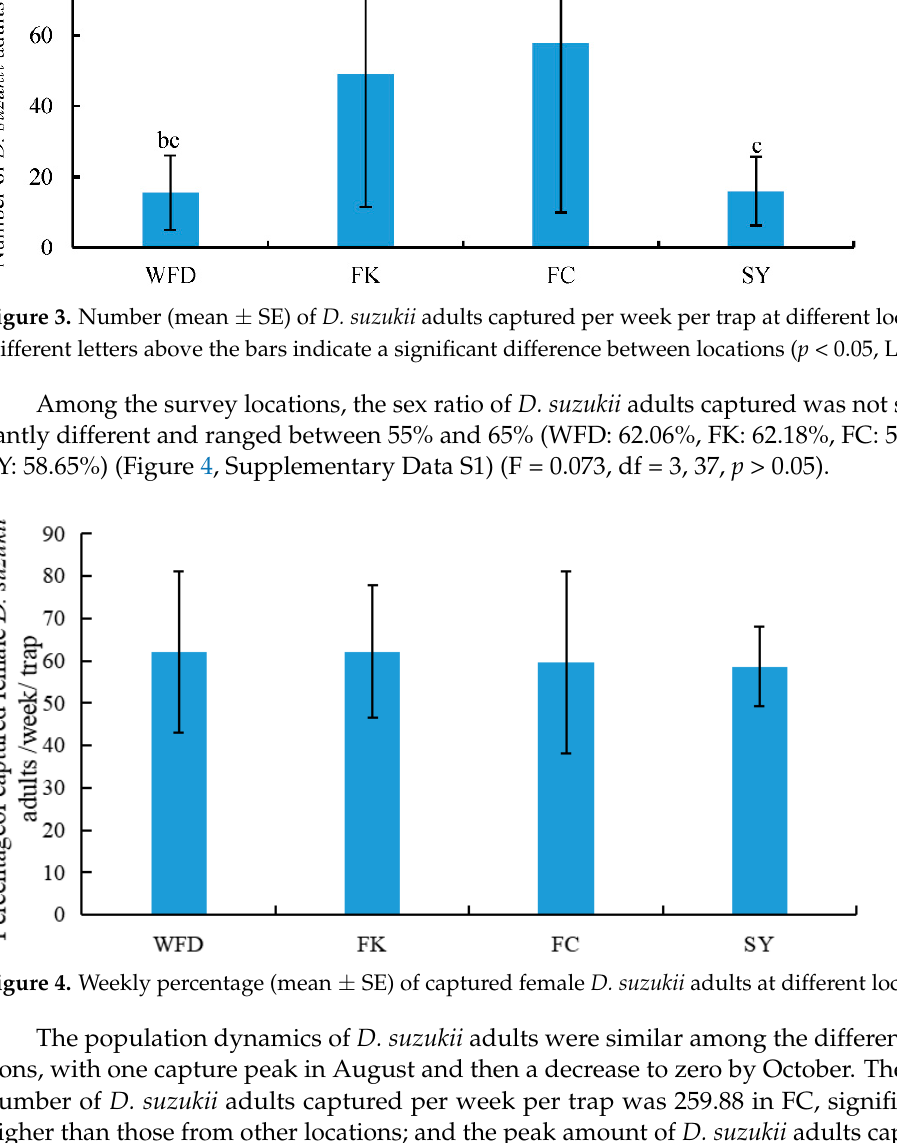
Figure 5. Mean number of D. suzukii captured per week per trap at the different locations. The num- bers on the curves indicate the sampling date (month-day). In WFD, 1–11 weeks start from 06-21 to 09-06. In FK, 1–14 weeks start from 06-22 to 09-28. In FC, 1–13 weeks start from 06-26 to 10-01. In SY, 1–5 weeks start from 07-02 to 08-06. The relative abundances of D. suzukii adults captured were not significant different between commercial fields and woods/wild bushes in WFD (F = 0.001, df = 1, 20, p > 0.05), FK (F = 3.985, df = 1, 24, p > 0.05), FC (F = 2.178, df = 1, 24, p > 0.05), and SY (F = 0.189, df = 1, 6, p > 0.05) (Figure 6, Supplementary Data S1).